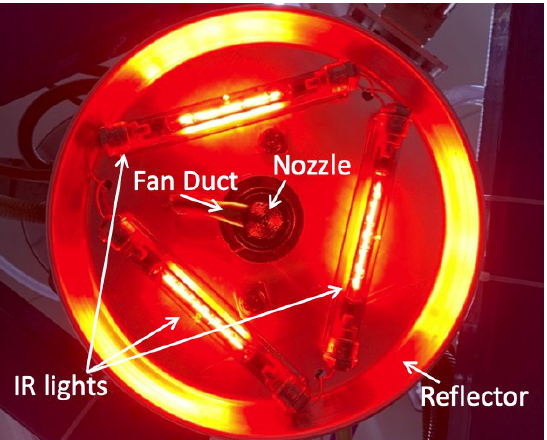
Figure 1. Bottom view of the reflector, which holds 3 IR heaters in a triangular layout and fan duct.